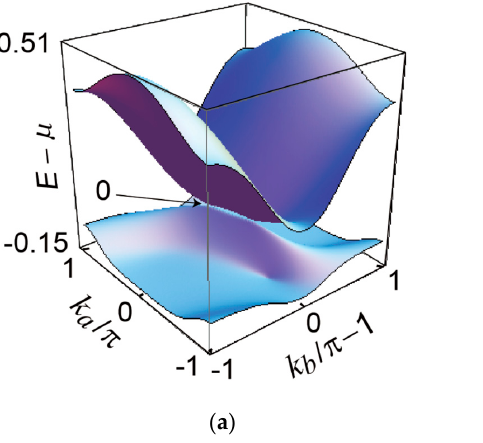
Figure 5. Structure of the top two bands in three-quarter filled bands based on the tight-binding model, where transfer energies t STF were assumed as t STF /eV = − 10 S STF, and the values of S STF were newly estimated using Equation (14) (Table 1) in this study. The tight-binding model, which is required in the band calculation using the values of t STF , is identical to that in our previous study [21]. The obtained band structure is different from our previous study [21]. ( a ) Conduction and valence bands given by E 1 (upper band; 0 ≤ E 1 ≤ 0.51 eV) and E 2 (lower band; − 0.15 ≤ E 2 ≤ 0 eV) as the function of wavevector k = ( k a , k b ). The lattice constant of the square lattice is taken as unity. The energy (eV) is measured from the chemical potential μ . The two bands contact with each other at the Dirac points ( k a / π , k b / π − 1) = ± (0.21, − 0.06) with the energy E D = 0.173 eV, which coincides with μ . ( b ) Contour plot of E 1 − E 2 with the energy range of 0 ≤ E 1 − E 2 ≤ 0.51 (eV). The Dirac points exist in the two darkest points in the orange region, which indicates 0 ≤ E 1 − E 2 ≤ 0.05 eV. The two Dirac points are close to merging at one of the TRIMs (time-reversal invariant momentum) X = (0, π ) since the contour is elongated toward the X point and E 1 − E 2 is much smaller than that at other TRIMs. 4. Conclusions We proposed a calculation method for intermolecular interactions in disordered systems based on the extended Hückel approximation. Despite the generally negative impression of the effects of disorder on cooperative properties, the physical properties and band structures of α -STF 2 I 3 indicated that the fine tuning of intermolecular interactions using disorder in organic CT complexes is an effective new method. This method enables electron densities between S and Se atoms as if there was no disorder in the solid state, which is otherwise impossible. The reconciliation of the established band theories with the disordered systems has remained uninvestigated for a long time. The calculation method proposed in this study was used to investigate the band structures of such systems in detail. It has not only revealed that α -STF 2 I 3 is a rare example of a system close to merging, but also that there is a novel electronic state requiring a wavefunction of the type of Equation (1) and the relevant assumptions. Author Contributions: T.N. developed the approximated calculation method of overlap and transfer integrals (Equations (1)–(23)) with discussion with Y.S.). Y.S. performed the band calculation (Figure 5) using the overlap integrals estimated by Equation (14). All authors have read and agreed to the published version of the manuscript. Funding: This work was partially funded by a Grant-in-Aid for Challenging Exploratory Research (18K19061) of JSPS, the Iketani Science and Technology Foundation (ISTF; 0331005-A), Research